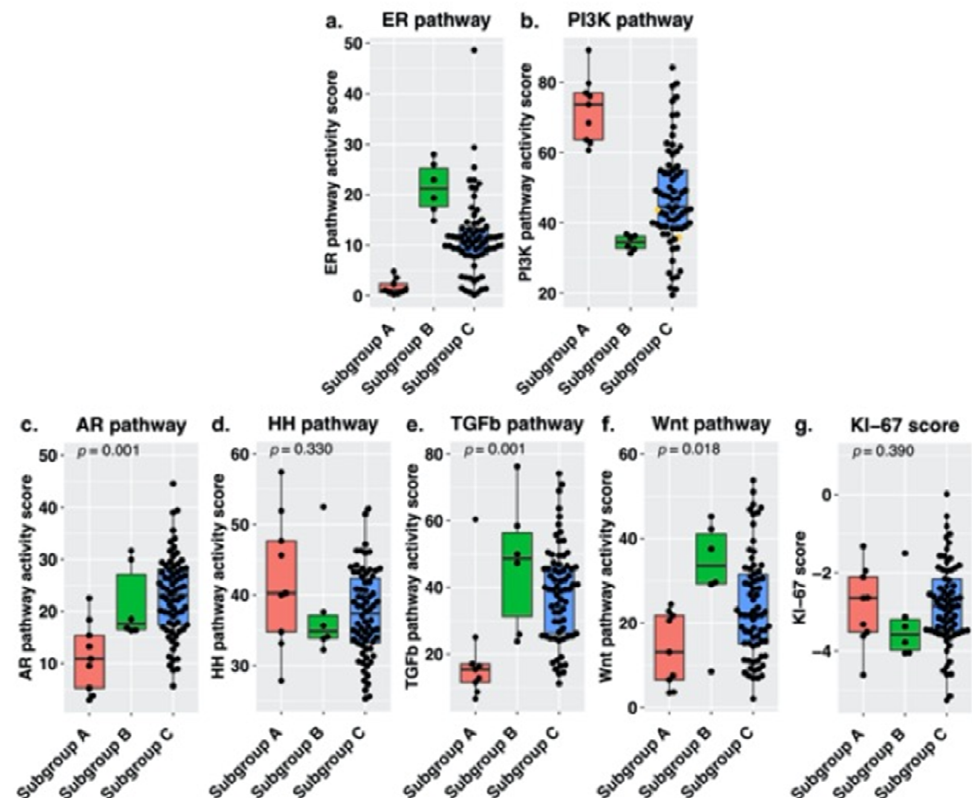
Figure 6. Signal transduction pathway activity measured in the newly formed subgroups containing high-grade serous carcinoma samples of both pre- and postmenopausal women, for the ( a ) estrogen receptor (ER), ( b ) phosphoinositide-3-kinase (PI3K), ( c ) androgen receptor (AR), ( d ) Hedgehog (HH), ( e ) transforming growth factor beta (TGF- β ) ( f ) canonical wingless-type MMTV integration site (Wnt) pathway and ( g ) KI-67 expression levels. Subgroups were based on ER and PI3K pathway activity. Subgroup A ( n = 9) contains samples with low ER pathway activity (quartile 1) and high PI3K pathway activity (quartile 4). Subgroup B ( n = 6) contains samples with high ER pathway activity (quartile 4) and low PI3K pathway activity (quartile 1). Subgroup C ( n = 70) contains the remaining samples. Median pathway activity was compared among the subgroups, p -values were derived using a Kruskal–Wallis test. The samples with high SOD2 levels are marked in